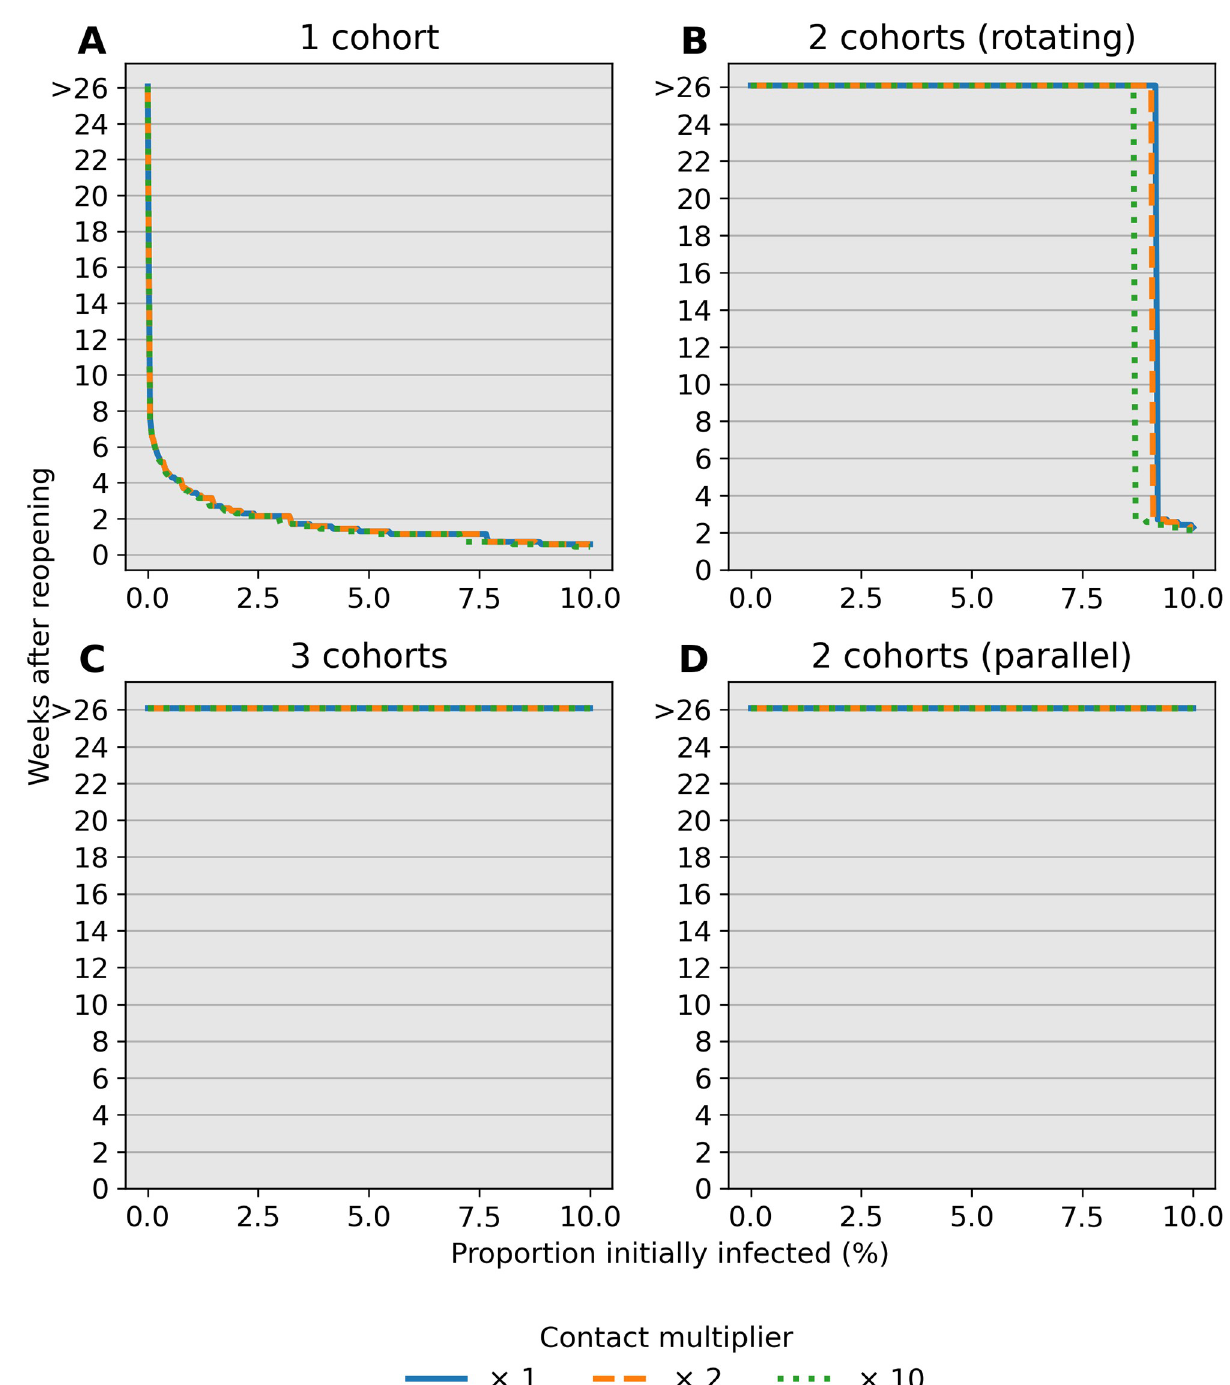
Fig 3. Number of weeks to reach a 5% stopping threshold in a community. Each scenario assumes a 100% sensitive test. The stopping time t threshold ( y -axis) is simulated under varying prevalence conditions at reopening ( x -axis). The contact multiplier for child-child transmission is also varied from (A) c = 1 to (B) c = 2 and (C) c = 10 and has little influence on stopping times. Multiple cohorts are effective at prolonging school operations while staying below a 5% prevalence threshold over a 14-day window. Note that only detected cases in children contribute to the decision rule.